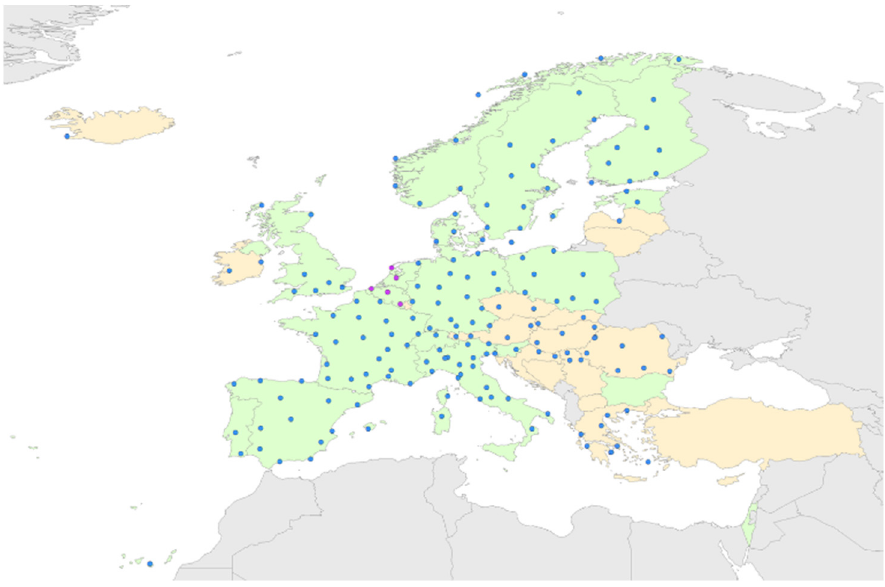
Figure 1. OPERA weather radar network.